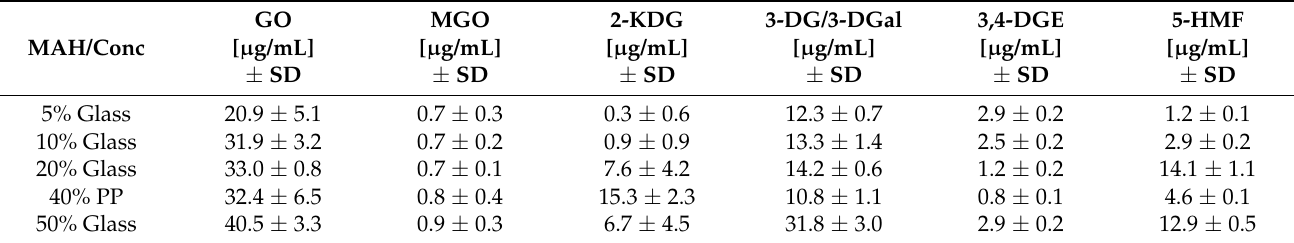
Table 9. Concentrations of GDPs. Manufacturer C ( n =